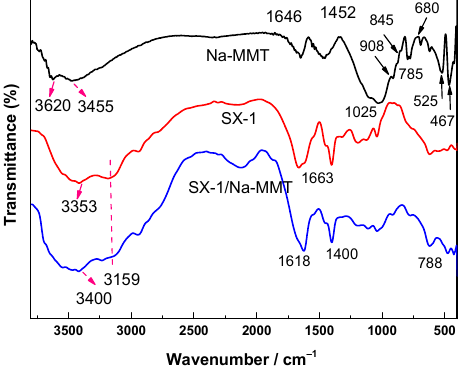
Figure 8. FT-IR analysis of the Na-MMT composites.